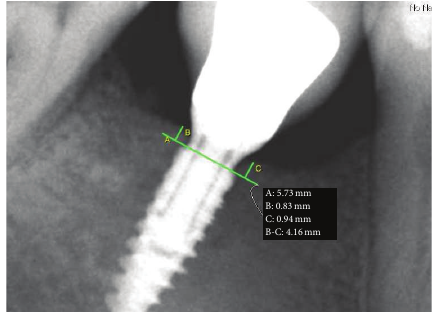
Figure 21: One-year radiographic